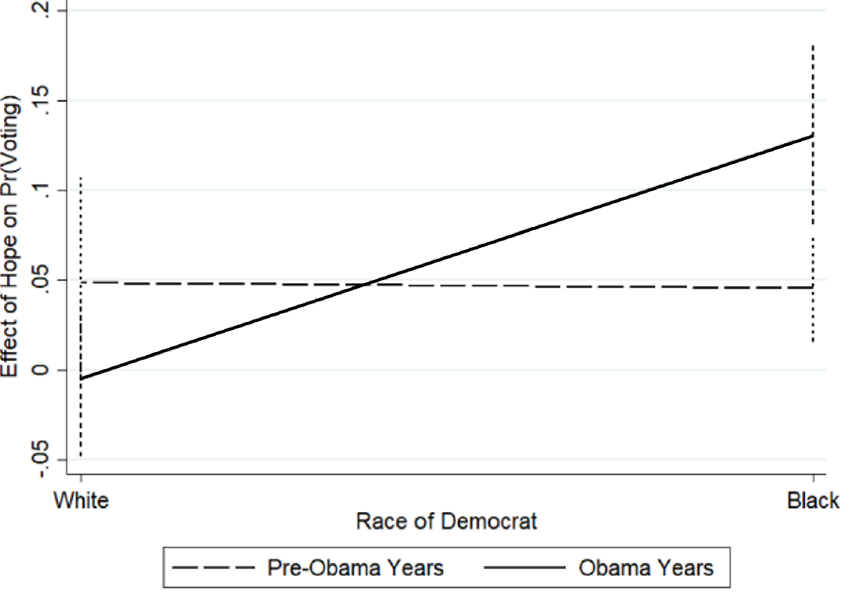
Figure 2. Predicted probability plots—Marginal effects of hope on vote likelihood, across Democrat race and election years. Includes 95% confidence